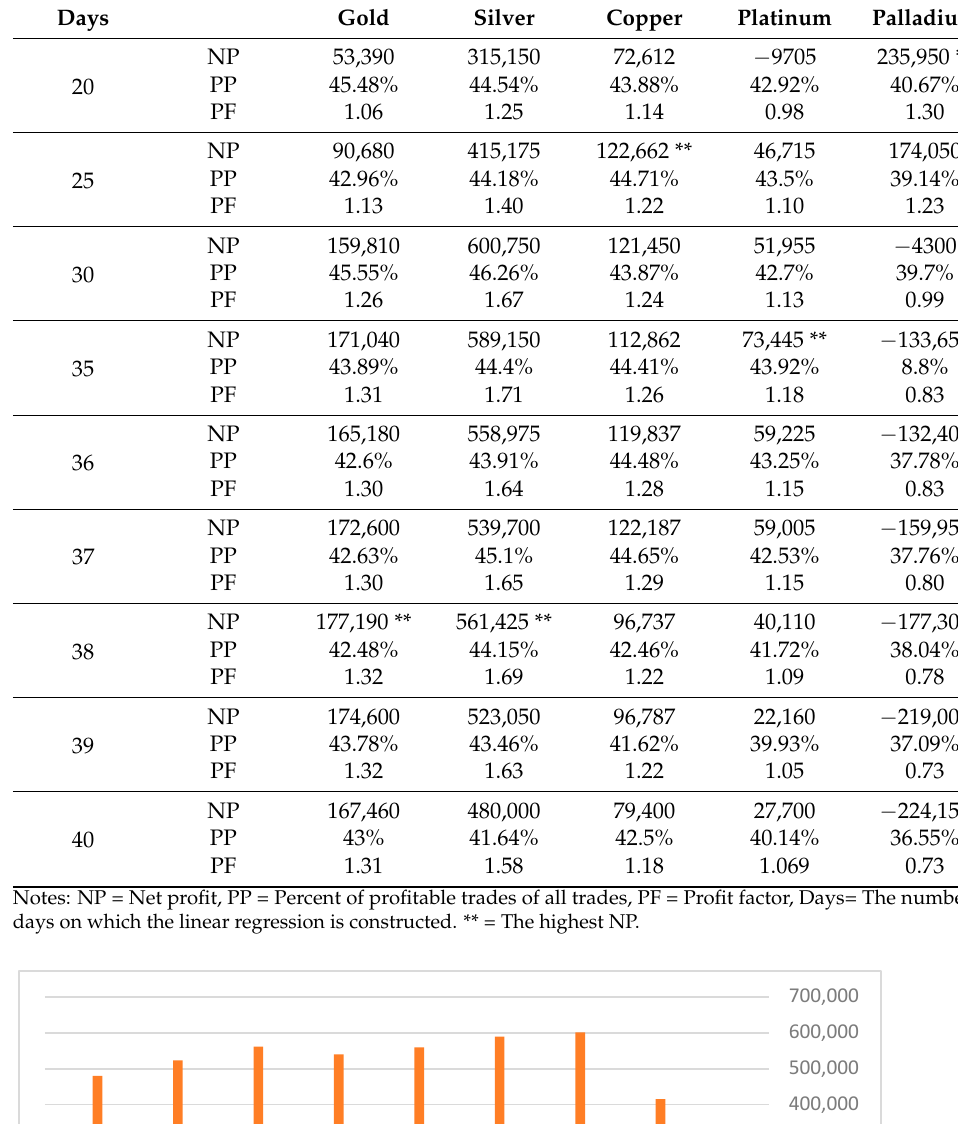
Table 4. Linear regression trading results of long/short strategies .